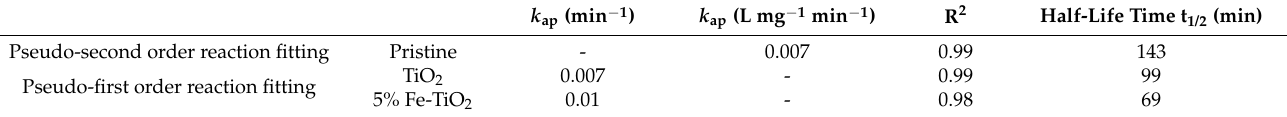
Table 3. Kinetic parameters (rate constants k ap , linear regression coefficients R 2 , and half-life times t 1/2 ) for RhB photocatalytic degradation under solar radiation with the pristine substrate (without catalyst) and the impregnated materials (with pure TiO 2 and 5 mol% of Fe-TiO 2 photocatalysts). k ap (min − 1 ) Pseudo-second order reaction fitting Pristine